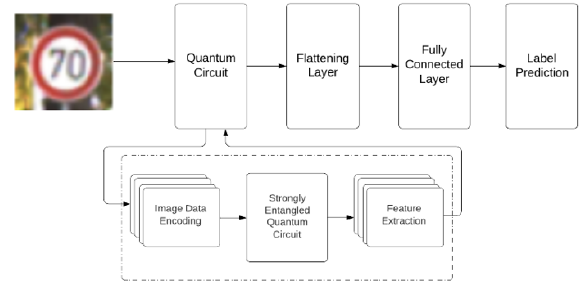
Figure 1. A flowchart of the proposed NNQE model.